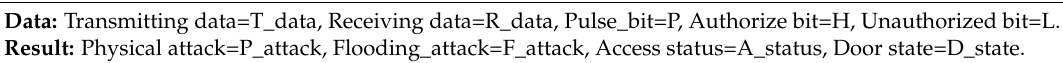
Table 5. Pseudocodes used in the proposed Security Improvement Framework (SIF) using Zigbee protocol implemented in an office security